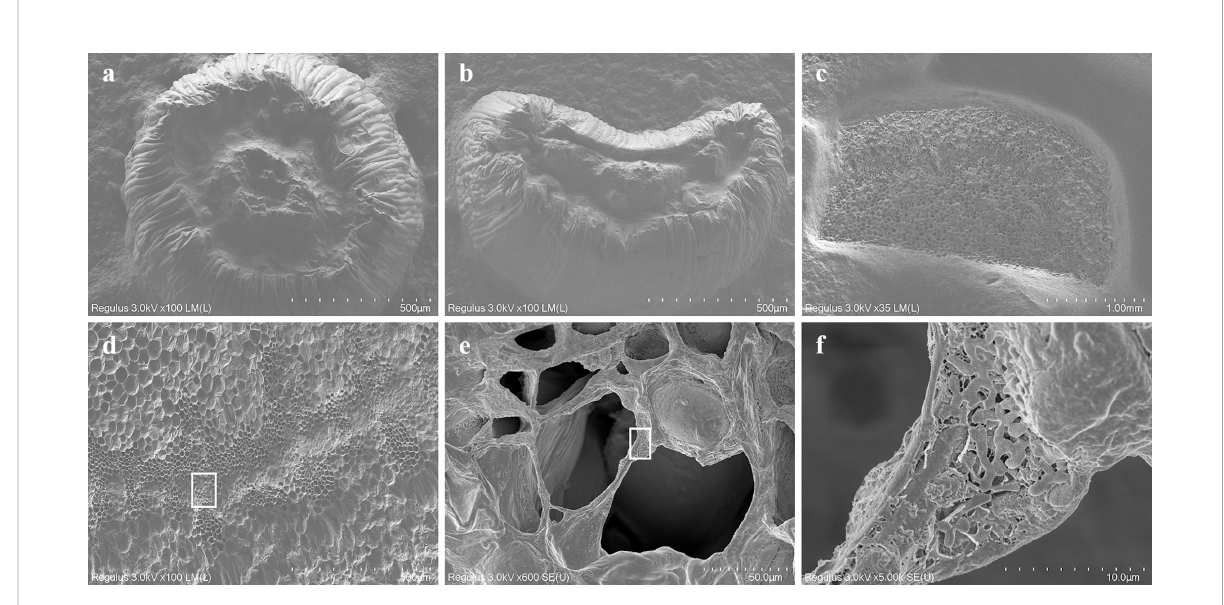
FIGURE 5 Cryo-electron microscopic observation of incisional tissues of three different explants. The incision morphology of hypocotyl (A) , cotyledon petiole (B) and curd peduncle (C) after infected with Agrobacterium tumefaciens and co-cultured for one day. (D – F) incision morphology of